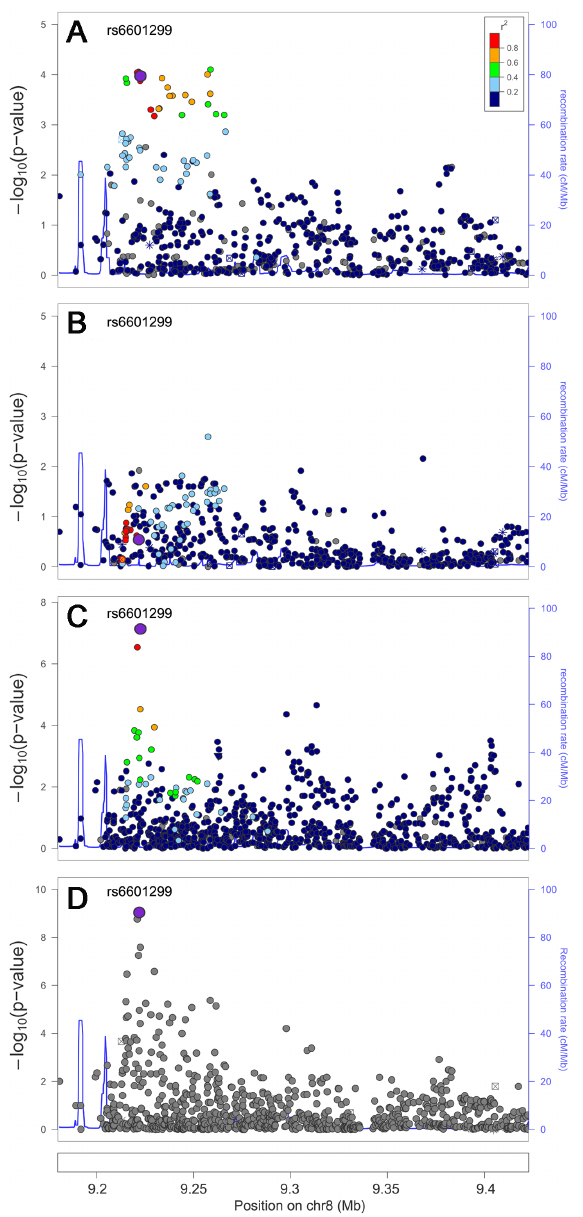
Figure 2. Trans-ethnic high-density genotyping narrows the association signal at the HDL-C locus PPP1R3B . Association in Europeans (A), East Asians (B), African Americans (C) and in a combined trans-ethnic meta-analysis (D). Index SNP rs6601299 colored in purple is the variant showing strongest evidence of association in the combined trans-ethnic